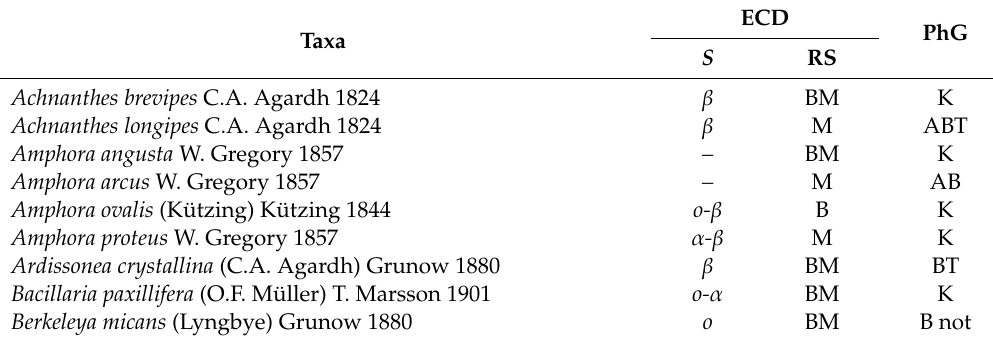
Table 1. Checklist of the epilithon diatoms in the Donuzlav Gulf of the Black Sea, 2018–2019 and their ecological and phytogeographical characteristics.